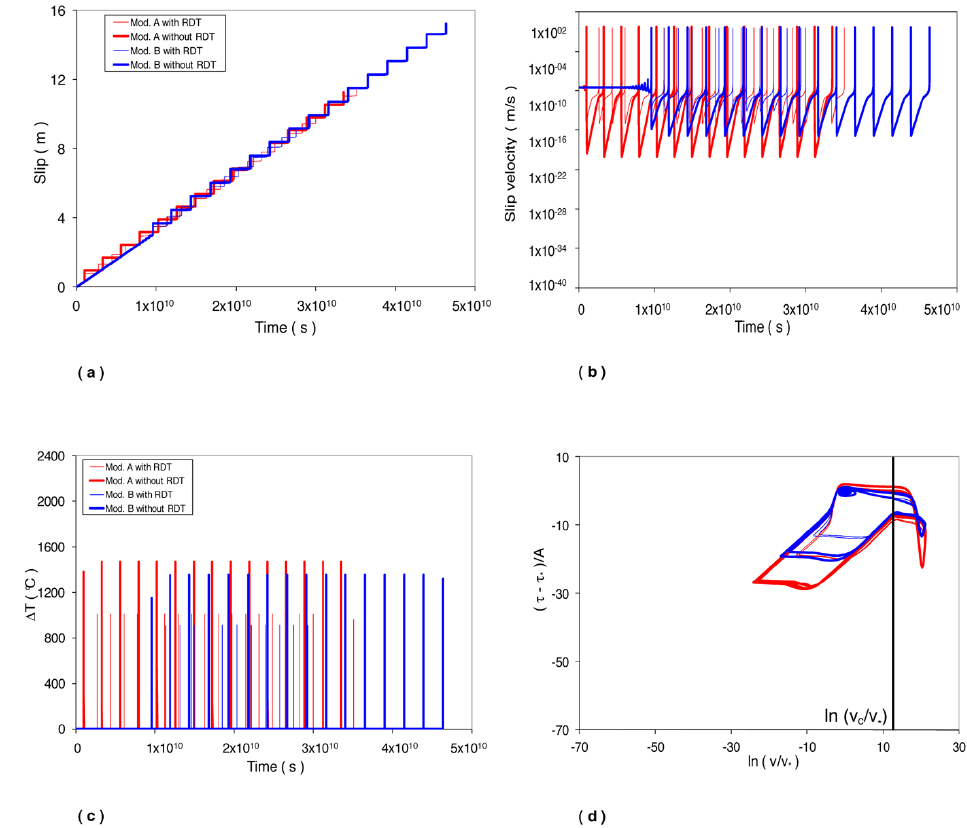
Figure 3. As for Figure 1, here related to the CH law (Equation 7).